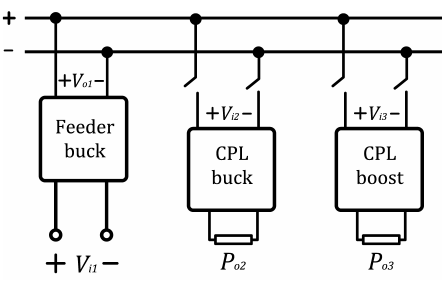
Figure 13. Proposed microgrid to be